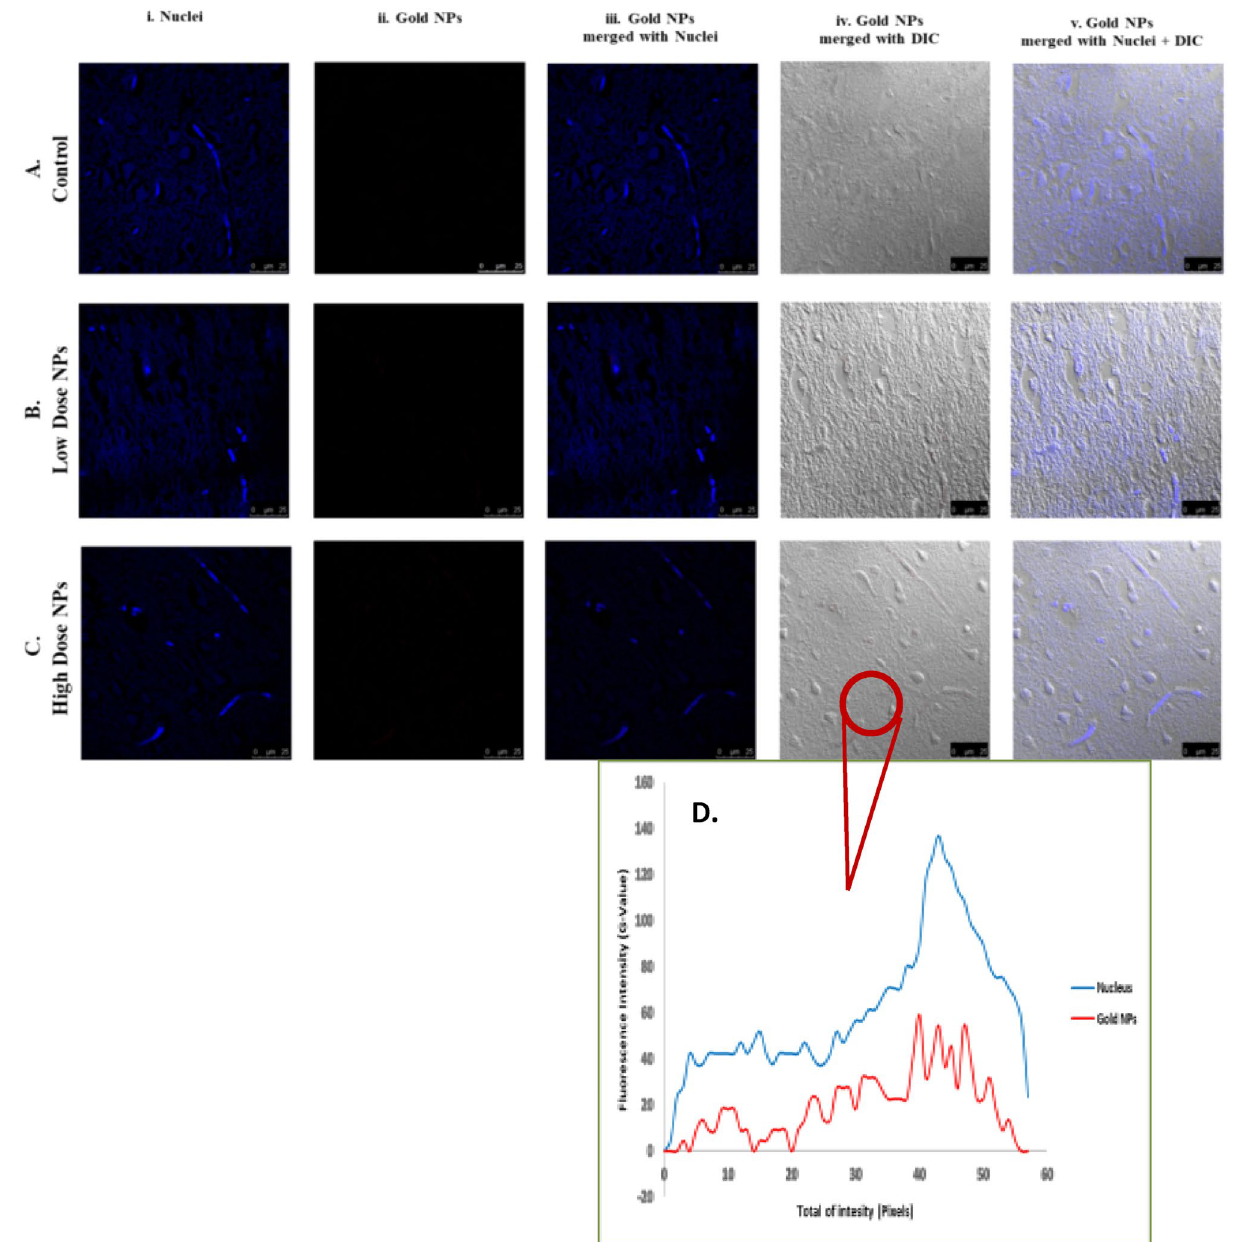
Figure 8. In vivo biodistribution and localization of Au-NPs at different doses (High & Low) in rat brain tissues after intravenous injection. [ A ] Confocal fluorescence images of rat brain tissues ( A ) Control group, ( B ) Rat group treated with high dose Au-NPs, and ( C ) Rat group treated with low Au-NPs . (i) Blue: Hoechst 33342-stained nuclei. (ii) Red: Gold NPs. (iii) Merged Image from Gold NPs and Nuclei. (iv) DIC mode merged with Gold NPs (v) DIC mode merged with Gold NPs and nuclei. λ max = 505 nm (Hoechst 33342), 555 nm (red autofluorescence from gold NPs), 473 nm (Differential interference contrast [DIC]). (Confocal Laser Scanning Microscope × 63, Scale bar: 25 μm, Scan Mode = XYZ Unidirectional X, Scan Speed = 400 Hz, Pinhole Diameter = 137.1 μm). ( D ) The relative intensity profiles revealed the Au-NPs signal completely overlapping with that of the nuclear staining of microglia, showed that although trace amounts of Au-NPs were crossed through the blood brain barrier, they were uptaken by microglia (circled